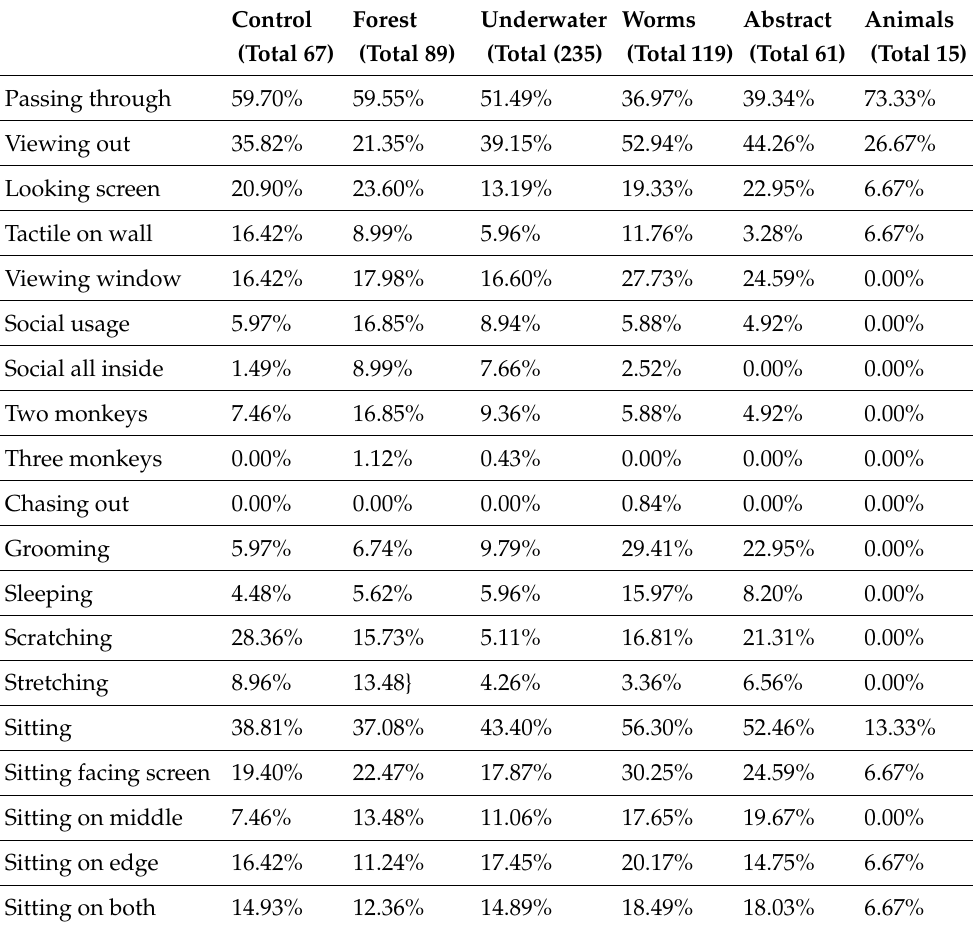
Table 6. Percentage of sakis behaviour with each visual stimuli